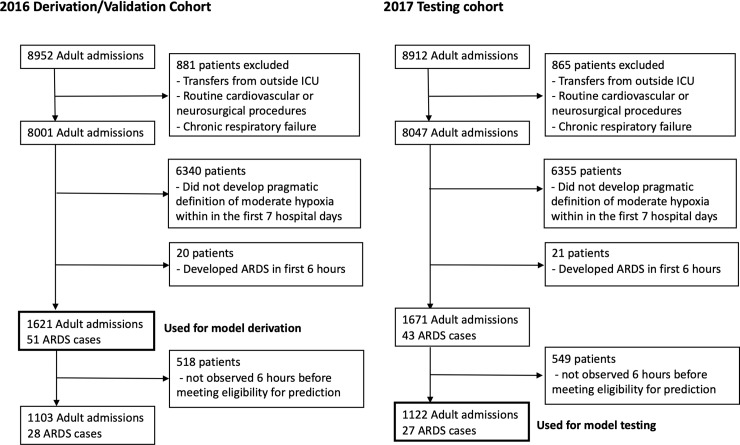
Study cohort.Flow diagram of 2016 model derivation cohort and 2017 testing cohort.